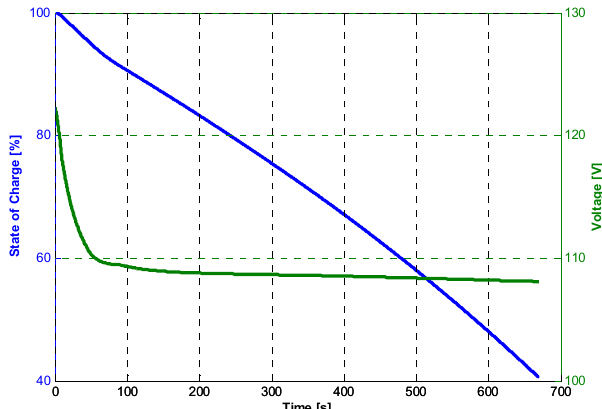
Figure 12. Real-time simulation of the case 11 Ah, n p = 21, n s = 29, 270 V on the DC-link: SoC (blue line) and output voltage (green line).